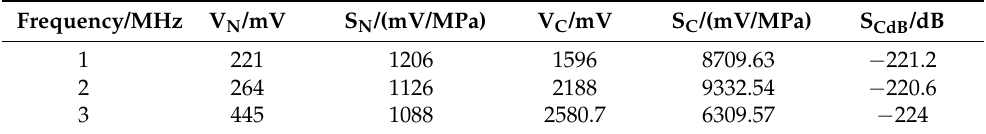
Table 4. Experiment results of packaged CMUT receiving sensitivity measurement.